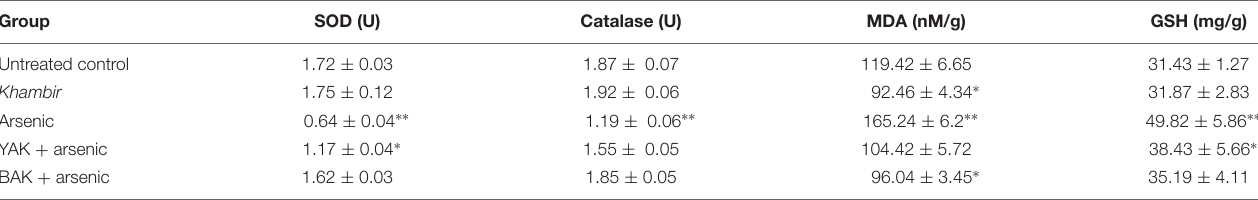
TABLE 4 | | Activity of antioxidant defense related biomarkers in intestinal epithelia during exposure of arsenic. Group